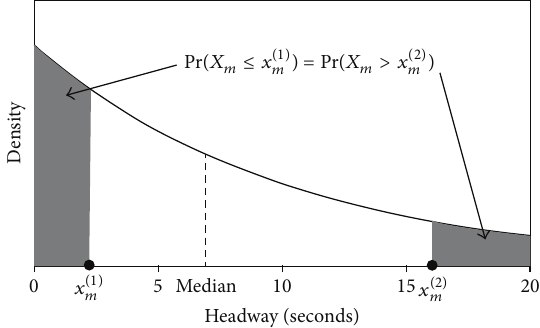
Figure 2: Simulated vehicle headways using